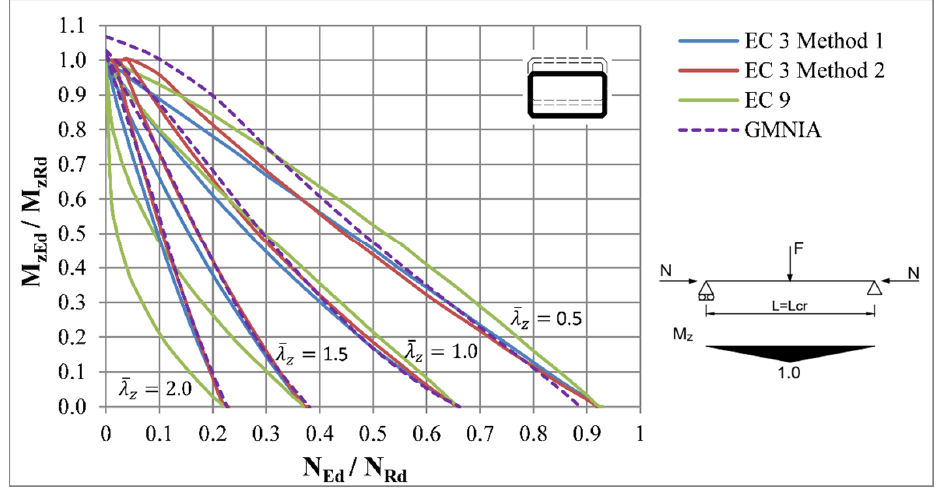
Figure 46. Interaction curves for weak axis flexural buckling of beam-columns with RHS cross-section.